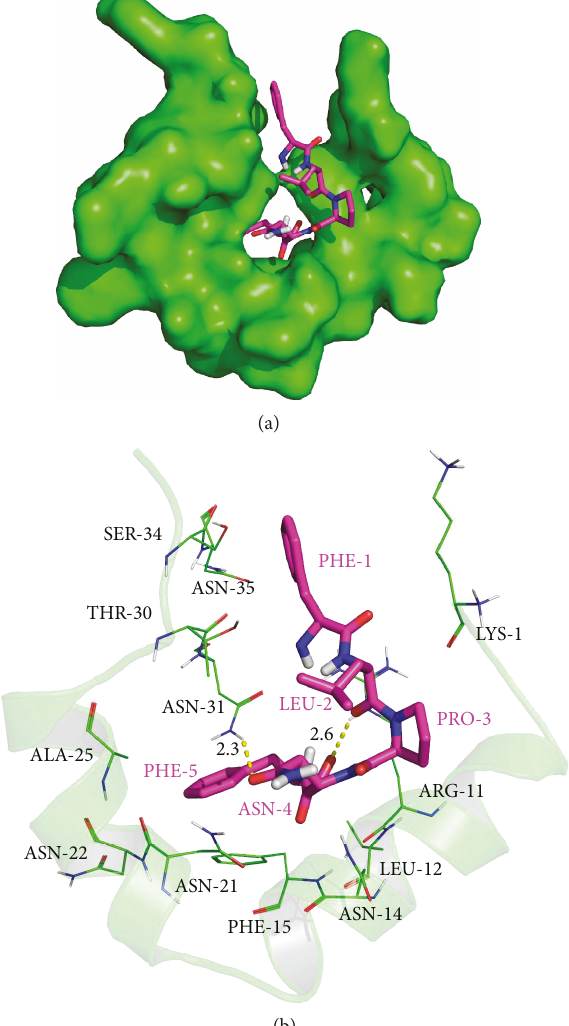
Figure 1: Molecular docking simulation of the interactions between FLPNF and hIAPP. (a) FLPNF was docked into the binding site of hIAPP (total view). (b) Detailed view of the binding mode between FLPNF and hIAPP. hIAPP was represented with cartoon, and the representative binding residues were shown in lines; FLPNF was represented with rose red sticks. The hydrogen bonds were shown as yellow dotted